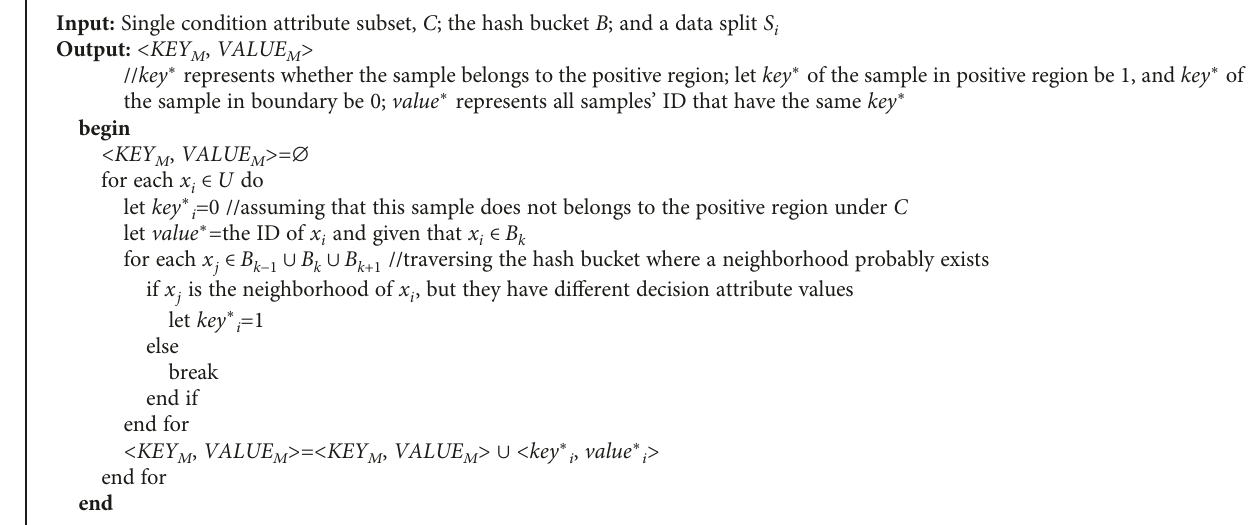
Algorithm 3: Single condition attribute subset neighborhood-Map.